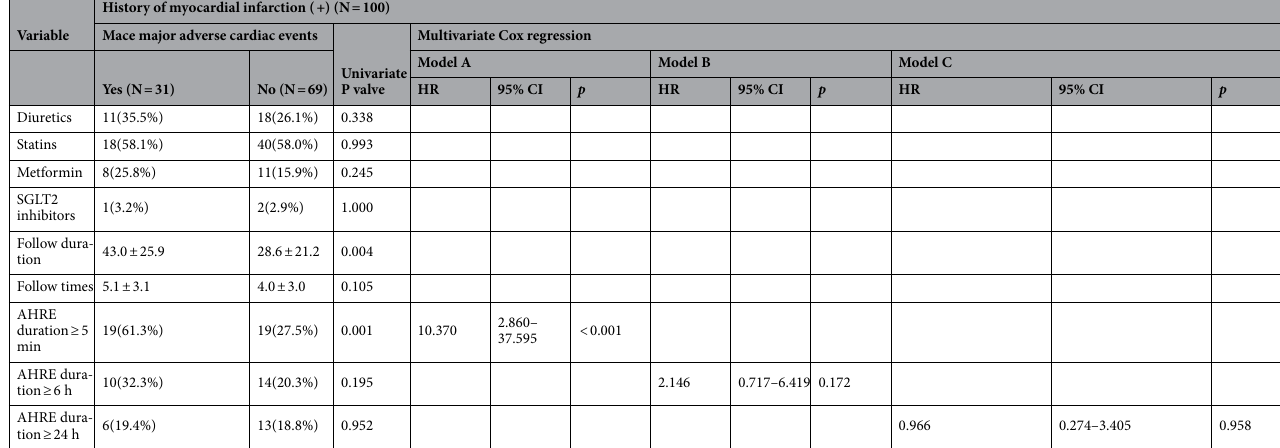
Table 7. Cox proportional hazard regression analysis with time-dependent covariates for MACE predictors in patients with history of myocardial infarction and with AHREs ≥ 5 min (Model A), ≥ 6 h (Model B), ≥ 24 h (Model C). Data are presented as mean ± SD or median, IQR or n (%). AF atrial fibrillation, AHRE atrial high-rate episodes, BMI body mass index, EF ejection fraction, IQR interquartile range, LA left atrium, LVEF